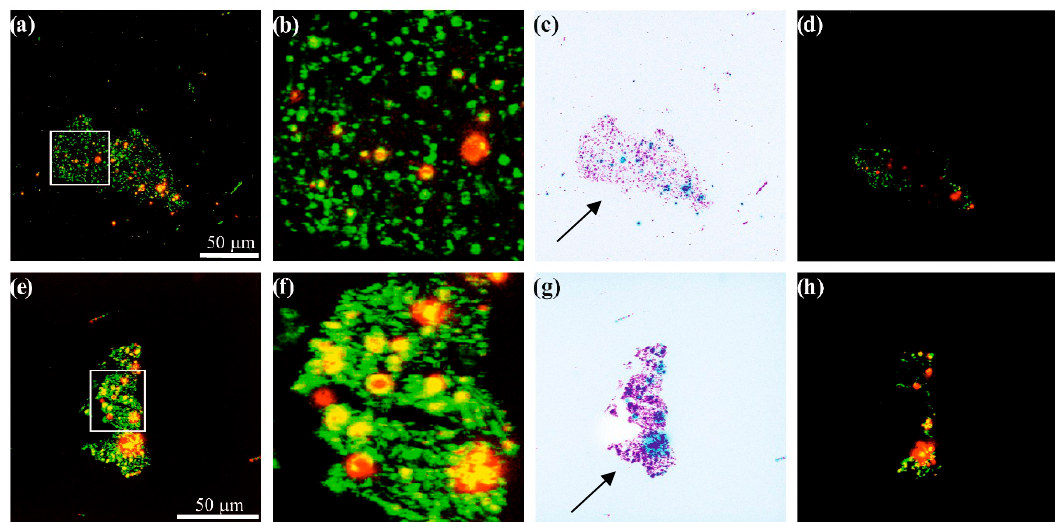
Figure 5. Confocal microscopy images for Norit_1_6T ( a – d ) and Norit_2_6T ( e – h ) samples, ( b ) and ( f ) present enlarged details from confocal microscopy images shown in ( a ) and ( e ). ( c ) and ( g ) provide inverted-colour versions of the studied materials. ( d ) and ( h ) show the last recorded images after using the laser beam.